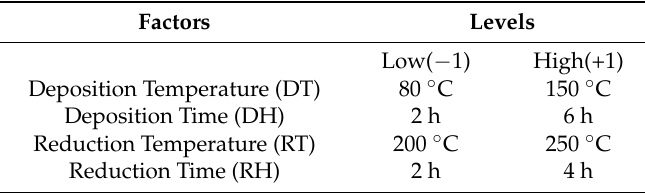
Table 1. Summary of the factors and levels included in the full 2 4 factorial design.